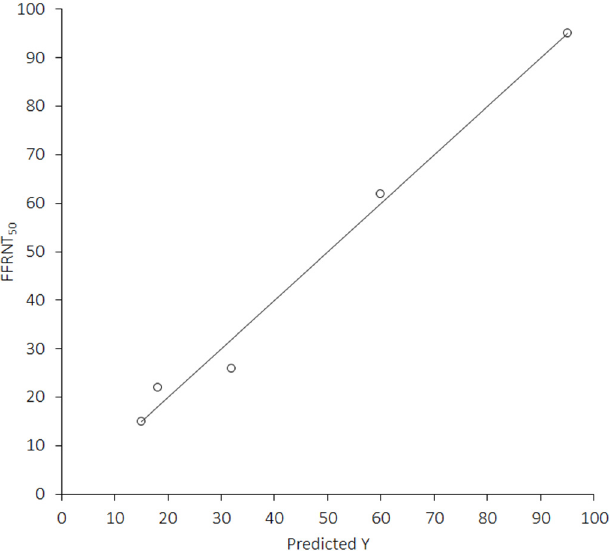
Figure 2. Scatter plot with fit of the mathematical model developed for predicting FFRNT 50 value for different SARS-CoV-2 Omicron sublineages in recipients of four doses of monovalent mRNA-based COVID-19 vaccines, with incorporation of emergence date of the sublineages, cumulative worldwide COVID-19 cases and cumulative number of COVID-19 vaccine doses administered worldwide at the time of SARS-CoV-2 Omicron sublineage emergence (the full equation is reported in the text).